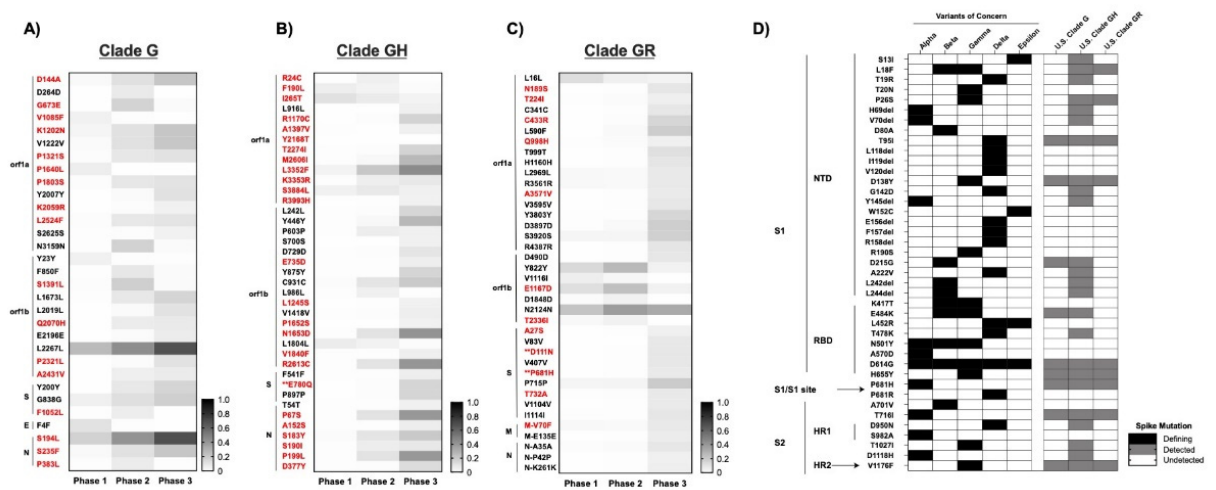
Figure 3. Emerged mutations in SARS-CoV-2 have increased in the U.S: ( A – C ) Non-clade-defining mutations of Clades G, GH, and GR. Emerging mutations are shown in which, during at least one Phase in 2020, the frequency exceeded 5%. Sequences were compared to the majority-consensus sequence for each respective clade in Phase 1. Mutation designations reflect the relative amino acid positions in the gene regions. There were no common mutations among the G-based clades. Red text denotes non-synonymous mutations. (**) Mutations that occur in T- or B-cell epitope regions. ( D ) Comparison of non-synonymous mutations and deletions in Spike between VOCs and the U.S. G-based clades across all three phases. The presence or absence of mutations is indicated by shading: VOC-defining mutations (black), mutations detected during at least one phase in the respective G-clade (gray), and undetected in either VOC or U.S. G-clades (white).